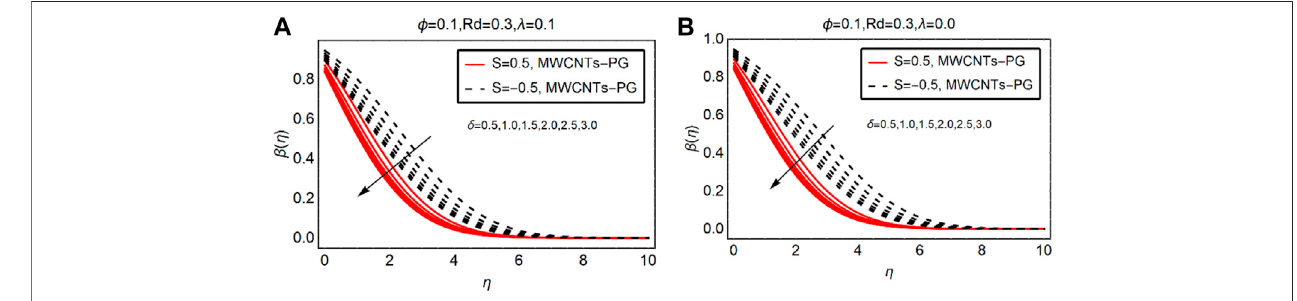
FIGURE 6 | β ( η ) against δ (A) λ > 0 and (B) λ (cid:2) 0.